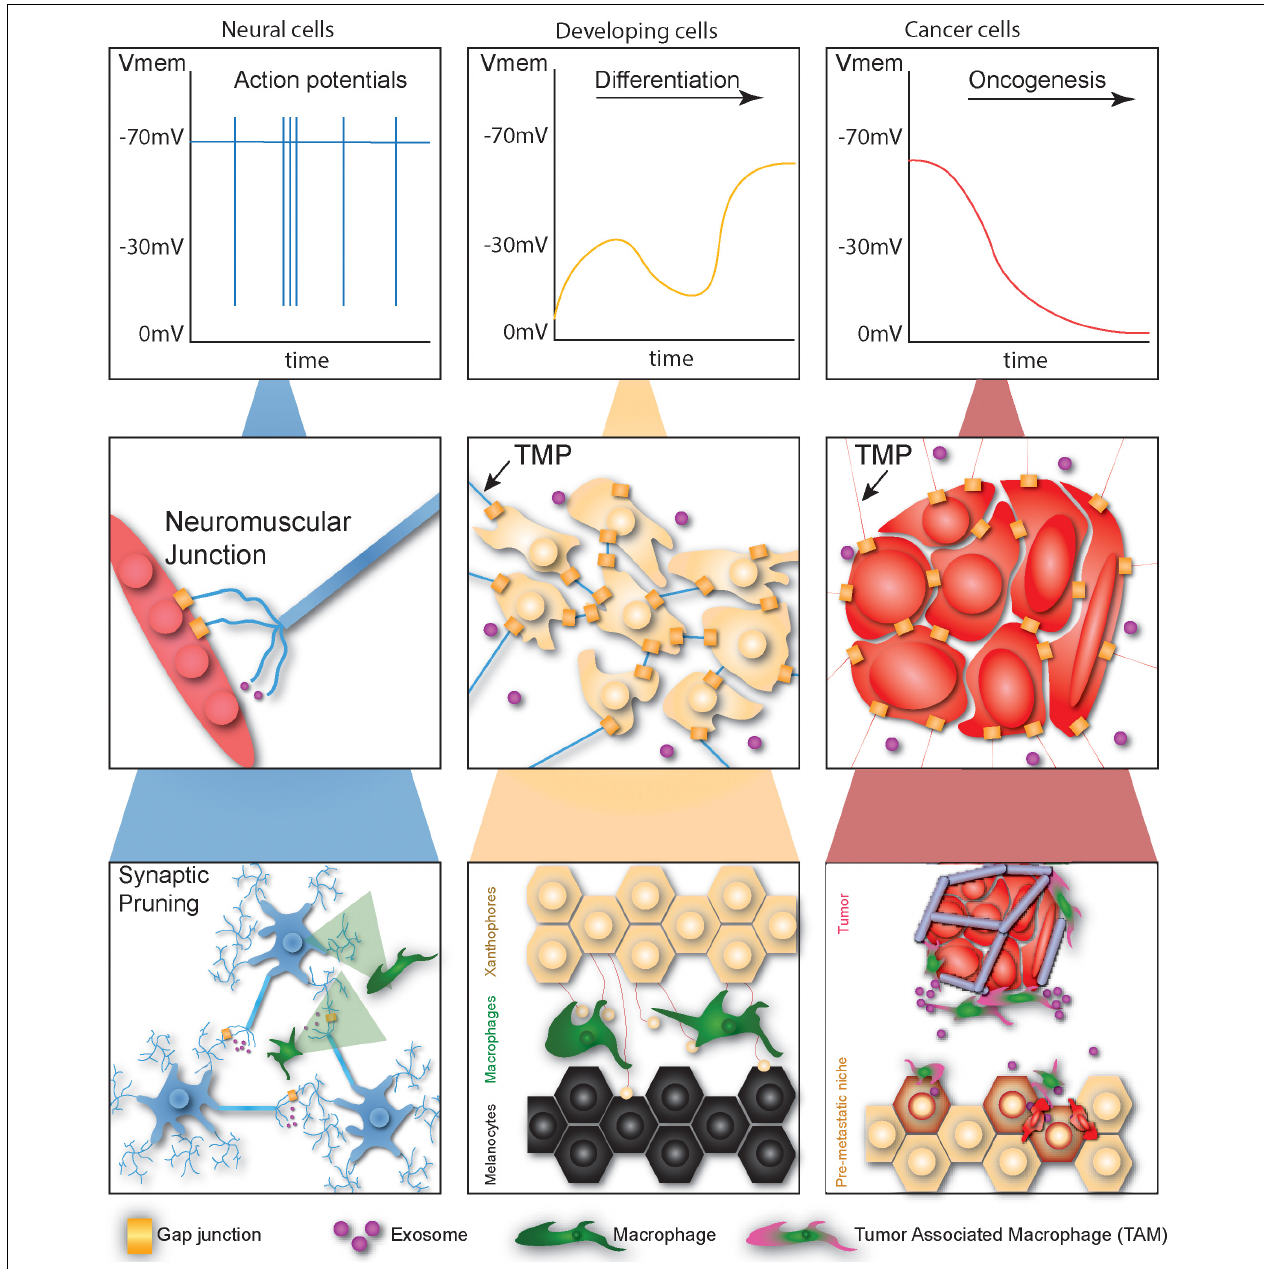
FIGURE 1 | Cells undergoing developmental or tumorigenic programs employ primitive non-neural communication methods for signaling at different scales. At the physiological scale neural cells signal via fast high-magnitude changes in membrane potential. Developing cells communicate via membrane potential fluctuations, though these changes are far slower and lower in magnitude. Cancer cells tend to depolarize over time, facilitating oncogenesis. At the local scale, neurons communicate directly with myocytes via gap junctions or translate bioelectric signals into chemical signals via vesicular release. Normal and cancerous non-neural cells likewise communicate at long distances via thin membrane protrusions (TMPs), gap junctions, and exosomes. At long-distance neurons form networks capable of complex computation regulated by the pruning activity of macrophages. Macrophages also establish networks of signaling projections between different types of skin cells during development and facilitate priming of the metastatic niche during cancer